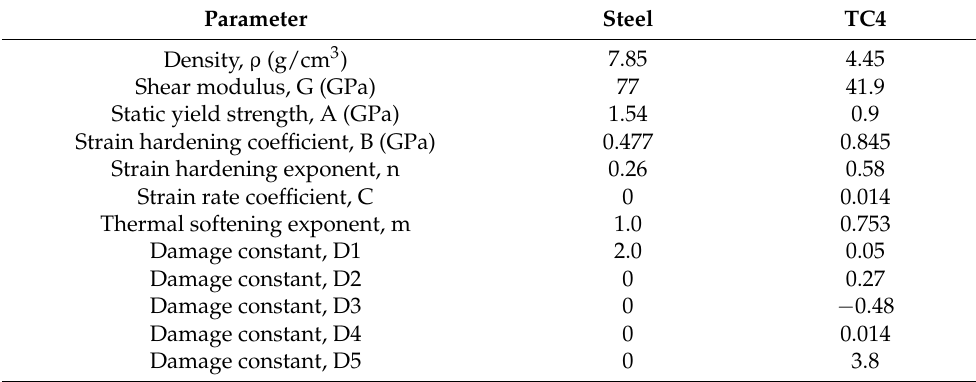
Table 5. Parameters of ceramic material in the Johnson–Holmquist-2 model [25].